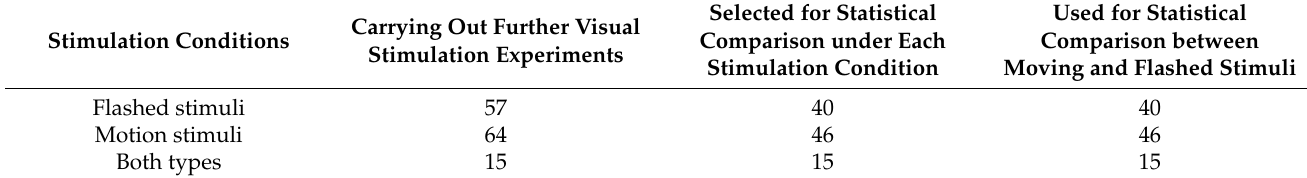
Table 2. The number of those who completed the whole visual stimulation experiments, or